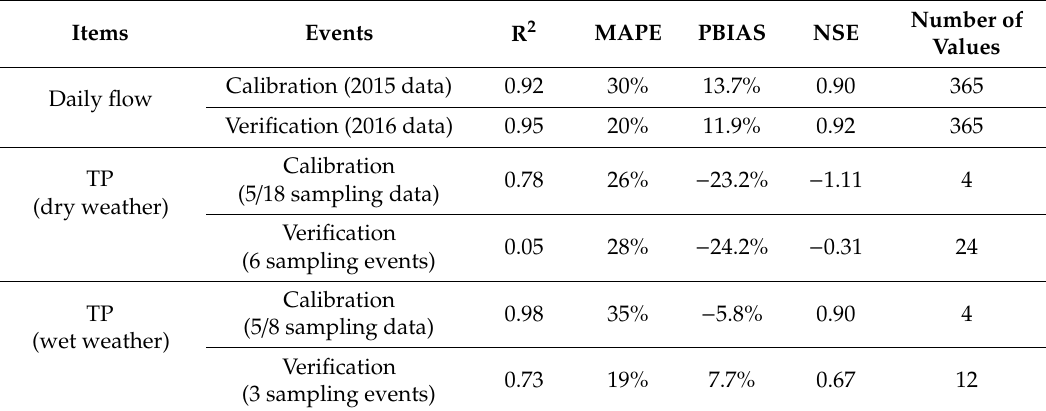
Figure 7. The TP simulations of wet weather events. The data of the 5 / 8 event are for calibration, and the other 3 events are for verification. Table 2. The results of SWMM simulations.